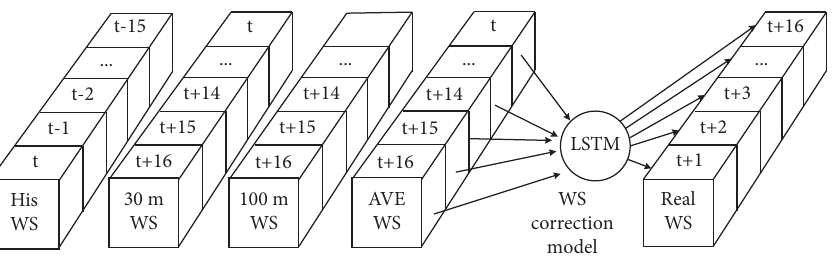
Figure 2: Wind speed correction strategy.